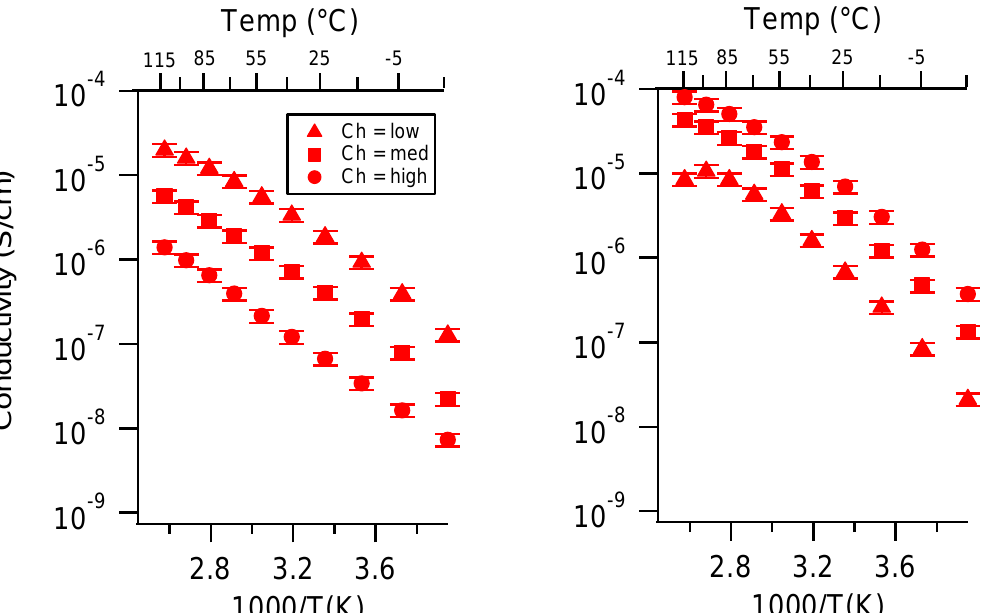
Figure A19. Conductivity as a function of charge density for PEGDMA1000_SSNa (left) and PTHFDA1000_STFSINa (right) SIPEs swelled with ECPC. Temperatures ranged from − 20 °C to 115 °C.